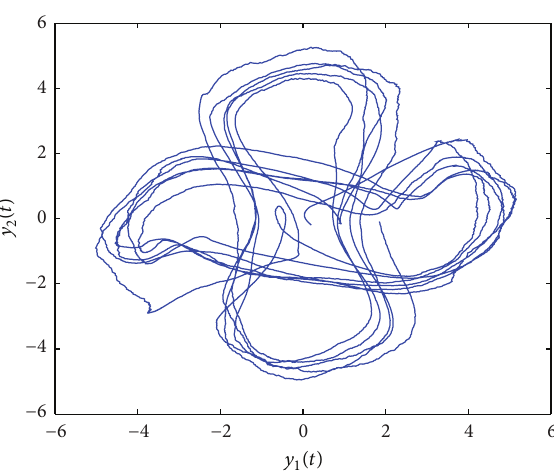
Figure 7: Control input 𝑢(𝑡) .